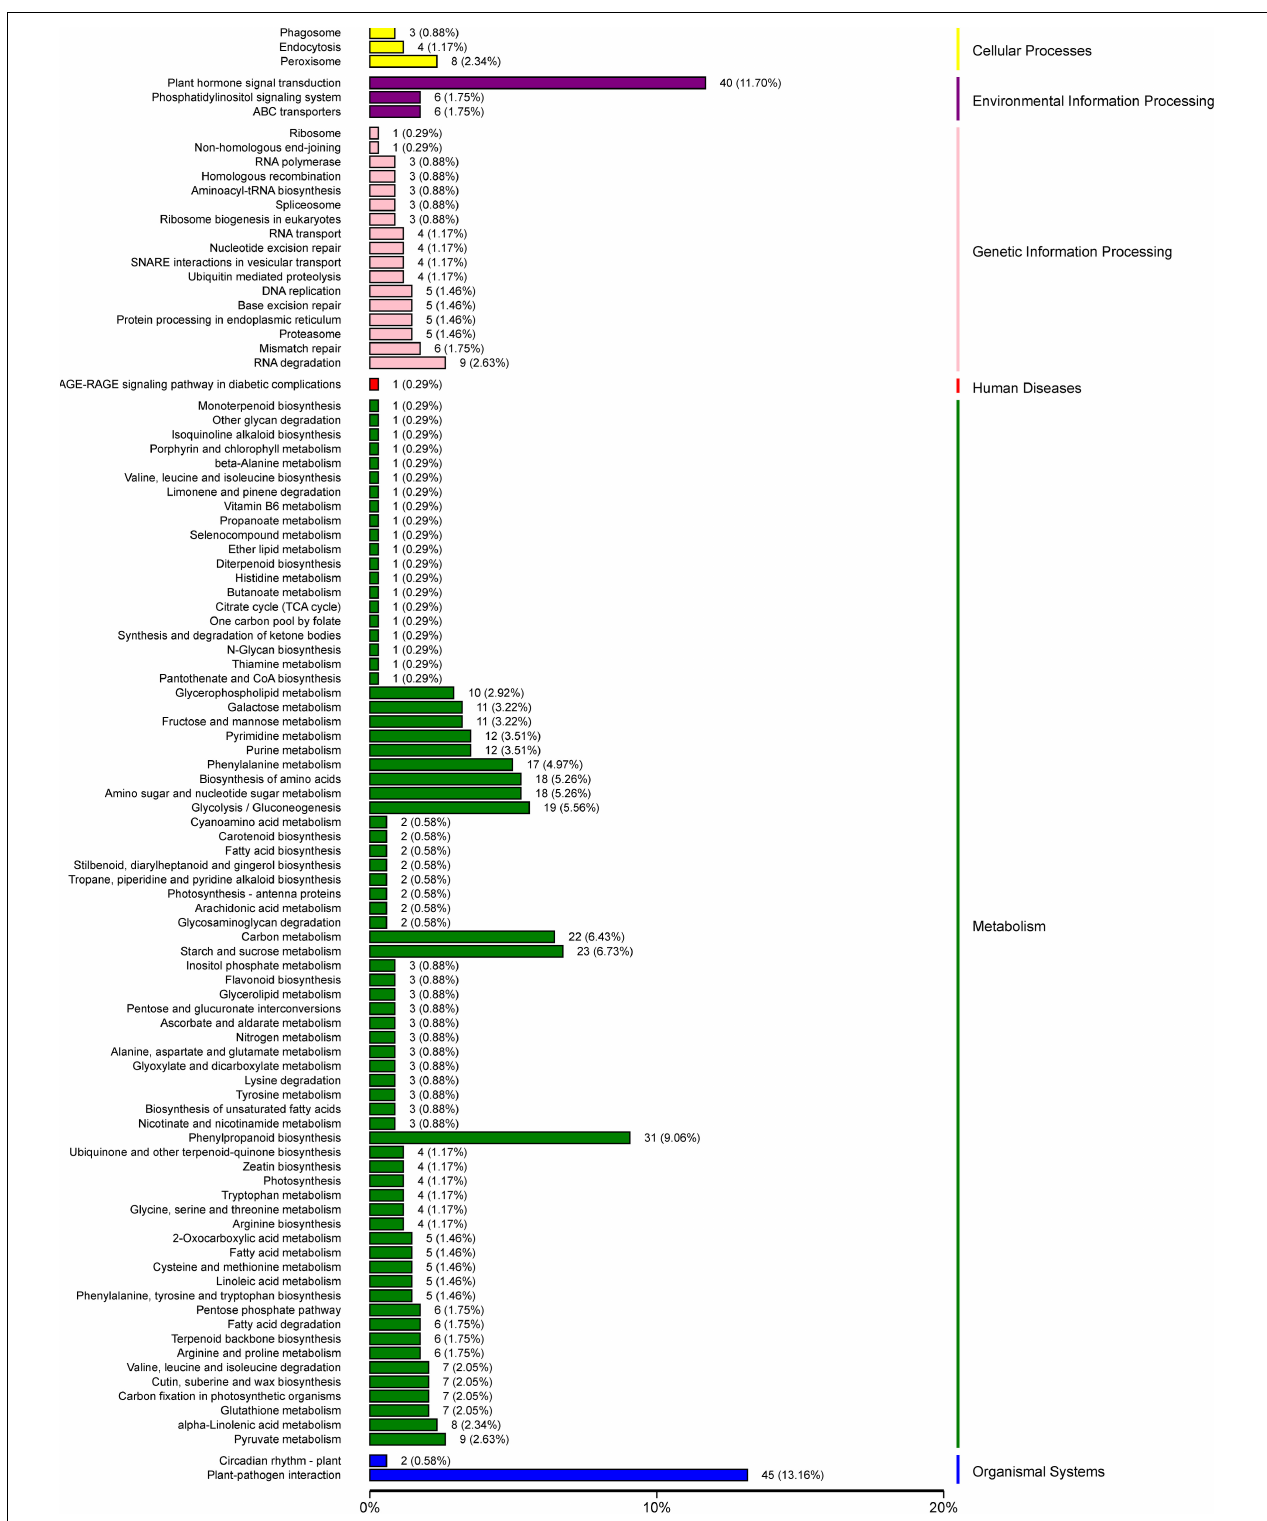
FIGURE 10 | Physiological and biochemical metabolic pathway KEGG enrichment analysis of 1,991 differentially expressed genes.